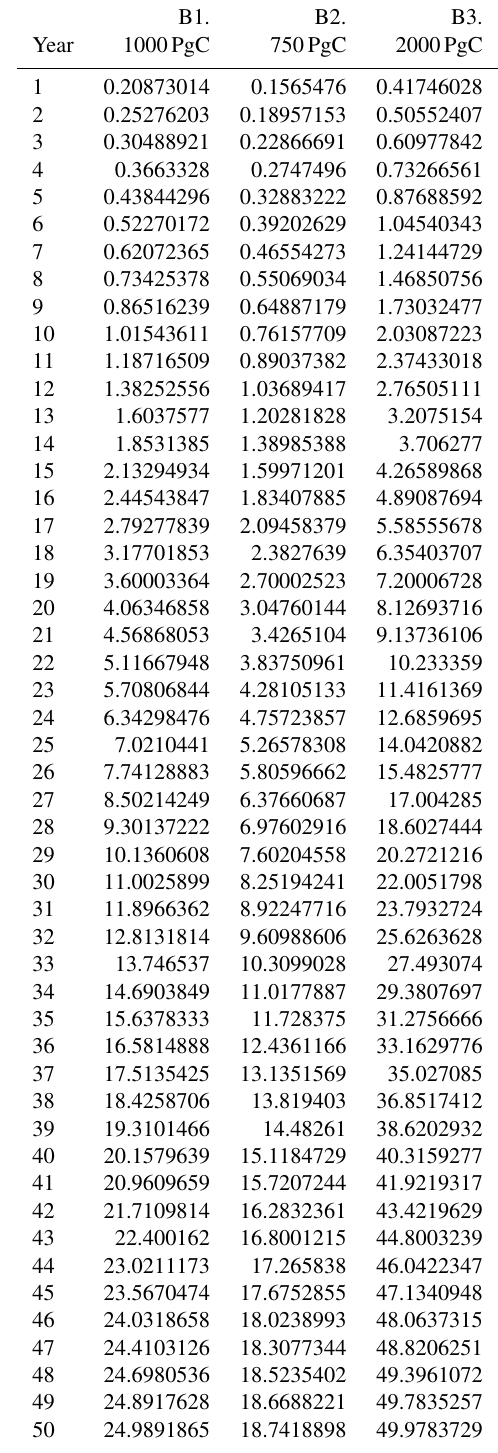
Table A1. Global CO 2 emissions (PgCyr − 1 ) to be applied during each year for the first 100 years of simulations